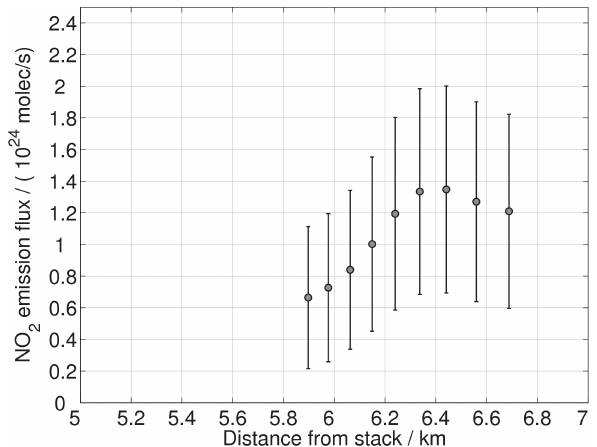
Figure 18. Emission flux estimates from the plume overpass at around 6km distance for the nine different viewing